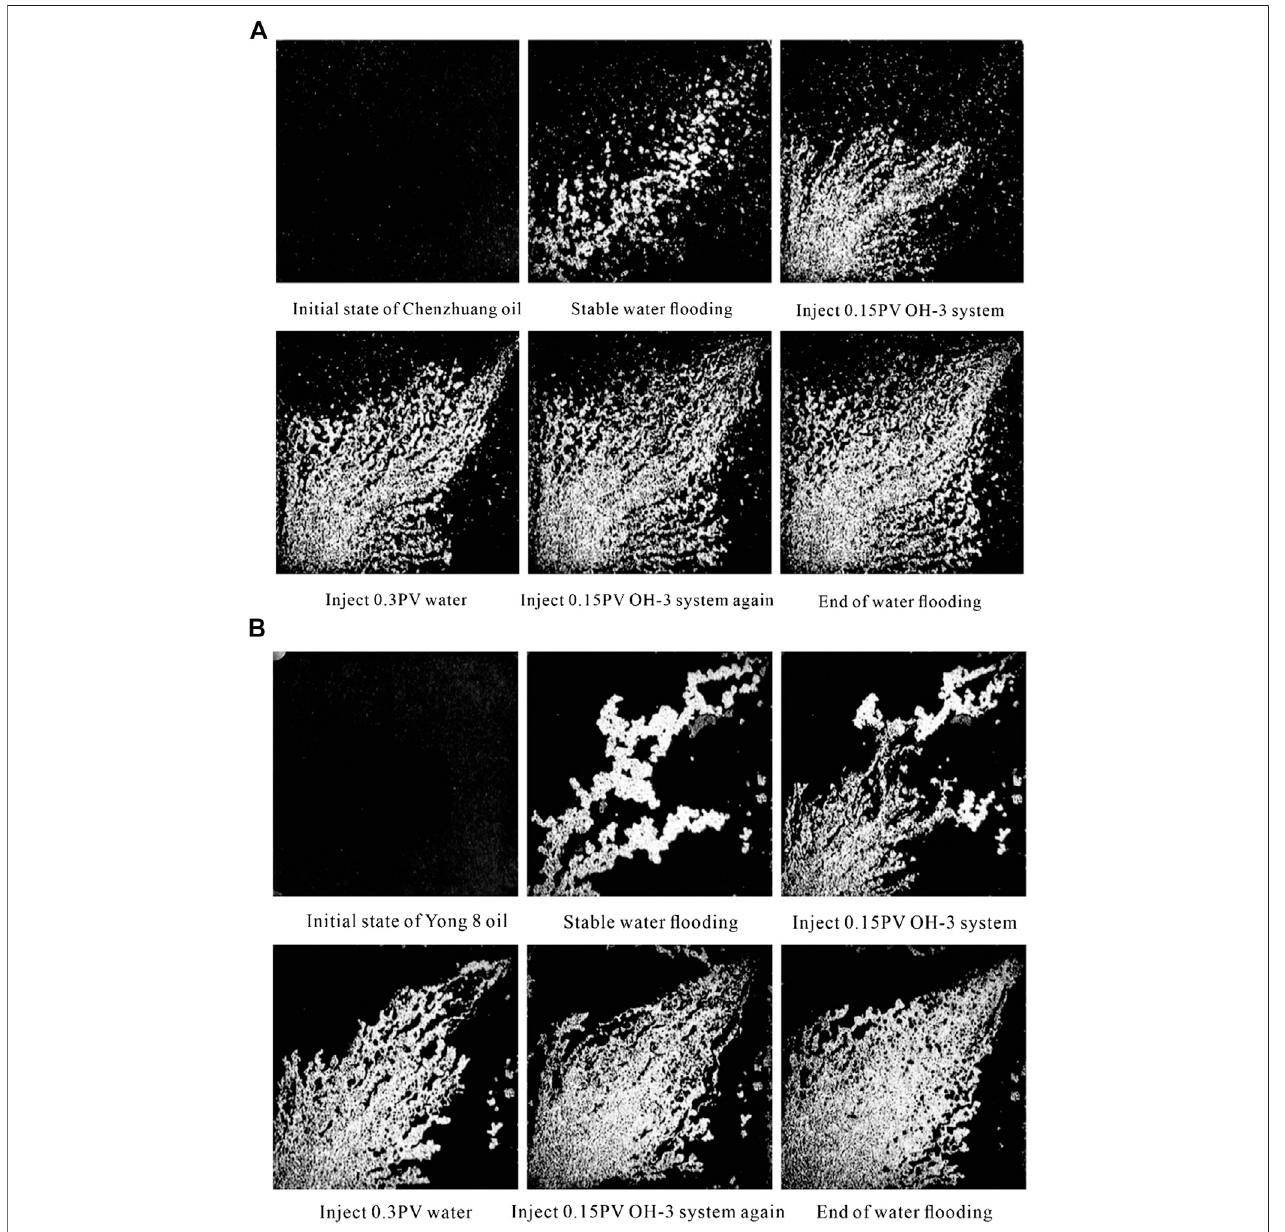
FIGURE 6 | Comparison of the recovery factor between single slug (0 – 1 water displacement, 1 – 4 oil-displacing agent injection, 4 – 5 the last water displacement) and double slug (0 – 1 water displacement, 1-2 fi rst oil-displacing agent injection, 2 – 3 water injection, 3 – 4 secondary oil-displacing agent injection, 4 – 5 the last water displacement) injection